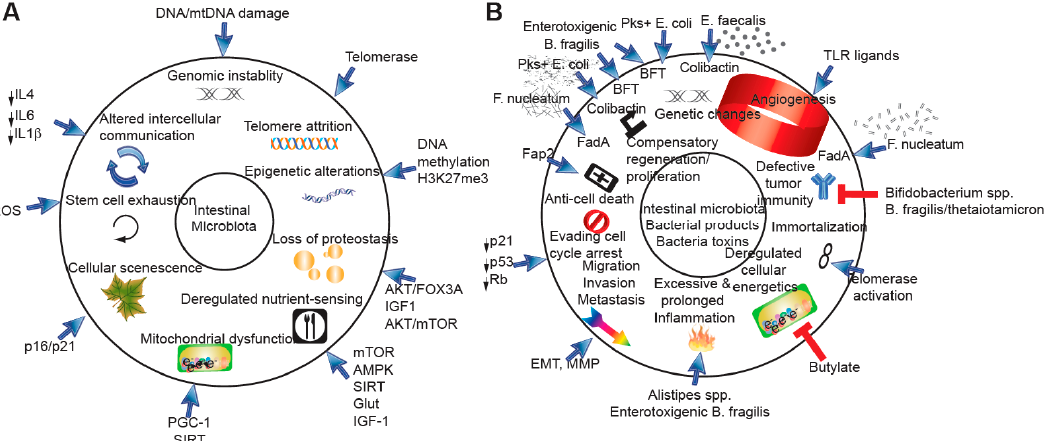
Figure 1. Intestinal microbiota and bacterial products. ( A ) Nine hallmarks of intestinal microbiota effects on host. ( B ) Summary of intestinal microbiota bacterial products, including bacterial toxins and their effects on the host.